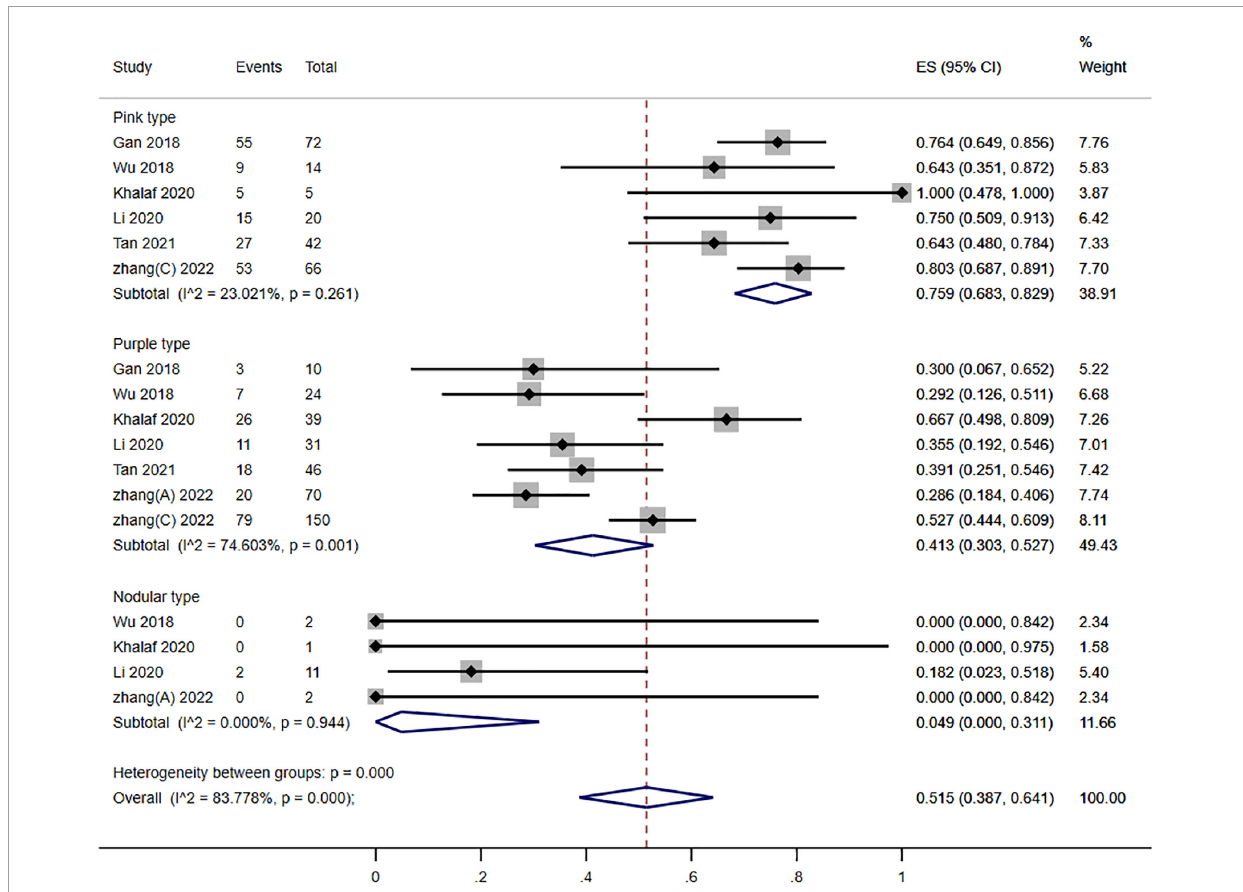
FIGURE6 Forest plot of photodynamic therapy (PDT) effects according to different types of port wine stains (PWS) ( ≥ 60%